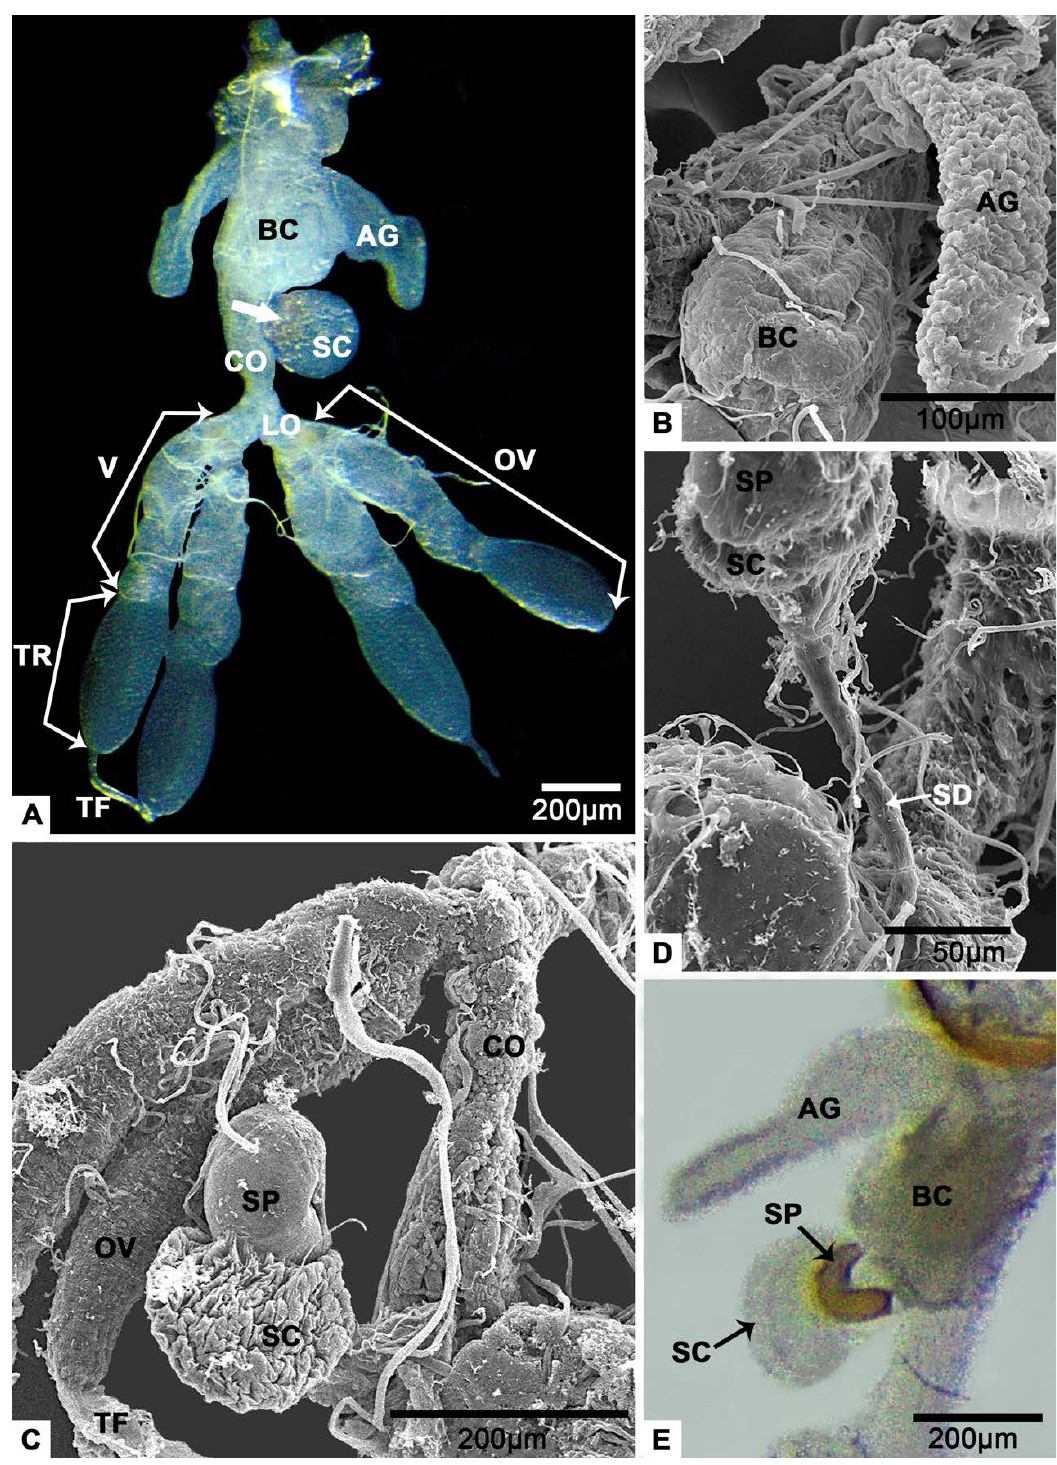
Figure 1. The female reproductive system of T. klimeschi on sixteenth day post-eclosion. ( A ) Light micrograph of the female reproductive system. The white arrow points to the spermathecal pump . ( B ) SEM micrograph of bursa copulatrix and accessory glands. ( C ) SEM micrograph of the female reproductive system. ( D ) The spermathecal duct. ( E ) Light micrograph of the crescent spermathecal pump and the spermathecal sac. Bursa copulatrix (BC); accessory gland (AG); spermathecal pump (SP); spermathecal sac (SC); spermathecal duct (SD); common oviduct (CO); lateral oviduct (LO); ovary (OV); vitellarium (V); tropharium (TR); and terminal filament (TF).